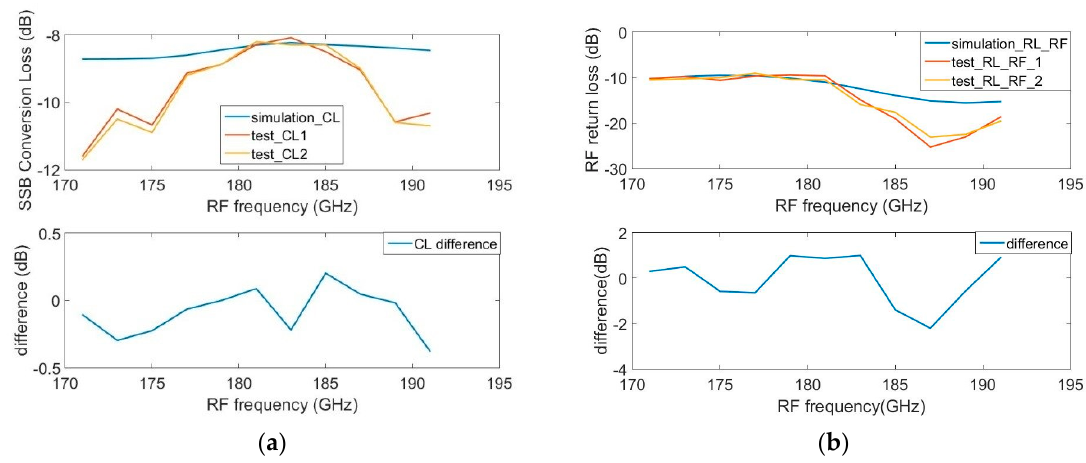
Figure 14. ( a ) Conversion loss test results of mixer 1. ( b ) RF return loss test results of mixer 1.